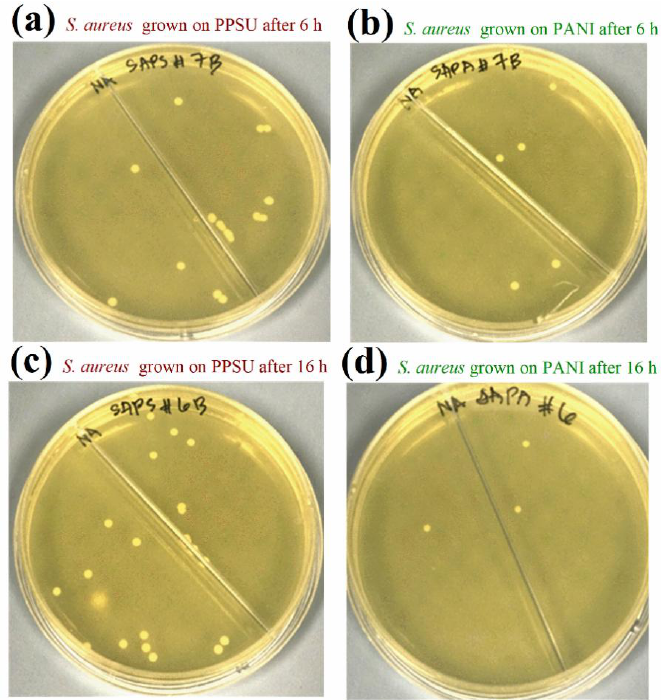
Figure 10. Antimicrobial properties of pristine and PANI-coated PPSU membranes assessed by plate counting. Plates incubated after the growth of S. aureus on a pristine PPSU membrane for ( a ) 6 h and ( c ) 16 h. Plates incubated after the growth of S. aureus on a PANI-coated PPSU membrane for ( b ) 6 h and ( d ) 16 h.